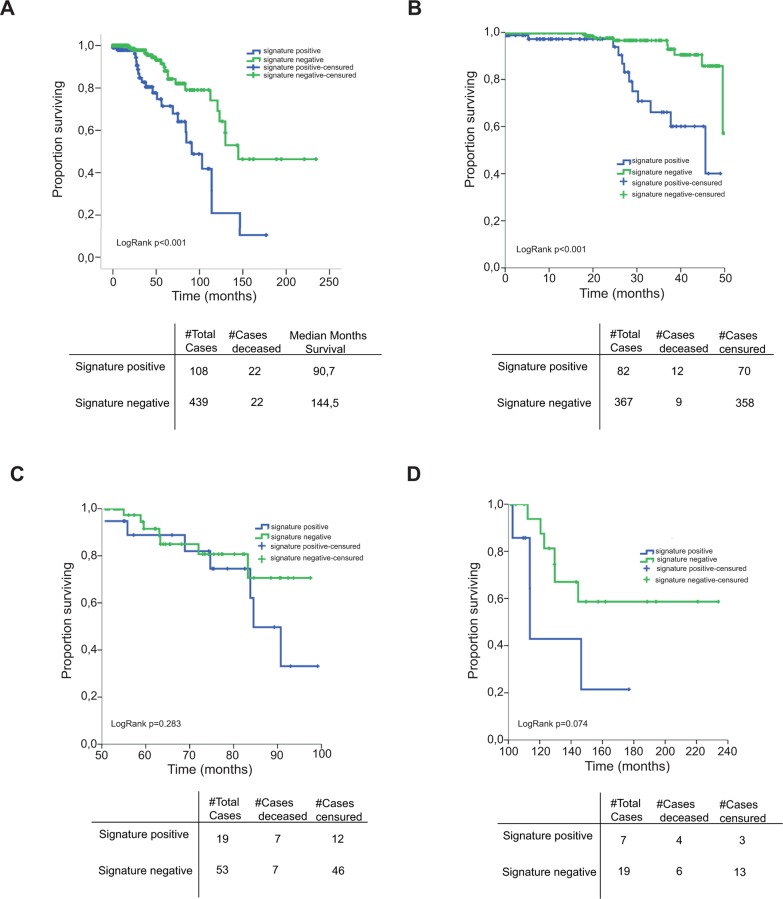
Kaplan-meier curves for patients positive versus negative for the signature.(A) Overall survival segregating patients by being positive (alteration in either MYC, EPHA7 and/or KMT2C) or negative (lack of alterations in the three genes) for the most parsimonious gene signature, showing the complete follow-up (250 months) of the TCGA HRPBC cohort. Log-rank test p<0.001. (B) Overall survival of the TCGA HRPBC cohort split by the positivity or negative of the three-gene signature during the first 50 months (log-rank p<0.001), months 50 to 100 (log-rank test p<0.283) (C) and beyond 100 months (log-rank p = 0.074) (D). It can be observed how the majority of the deaths in the three-gene positive patients occur during the first 50 months, when they are receiving adjuvant hormonal treatment. "Signature-positive" means having an alteration with functional impact (mutation, amplification/deletion, mRNA expression up- or down-regulation) in either of the three genes according to the TCGA data; "Signature-negative" means lack of alterations in the three genes.